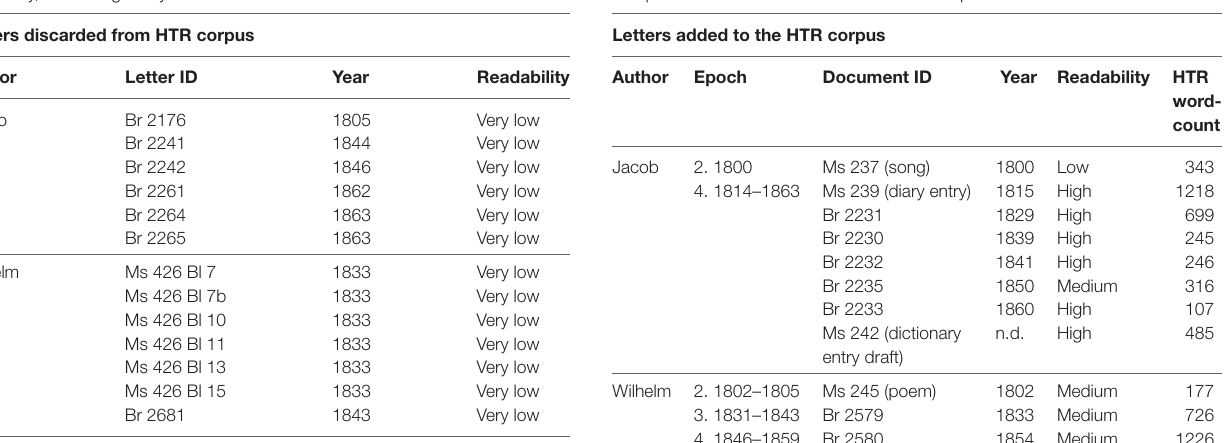
Table 4 | The 11 documents added for the second run of the HTR to compensate for the loss of 13 letters from the previous run.